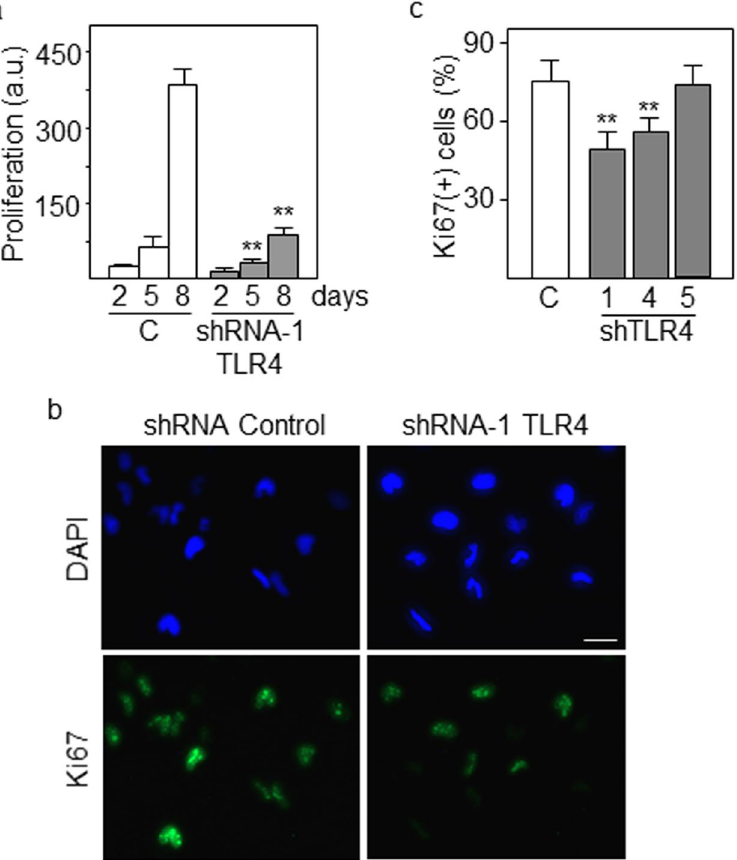
Figure 4. Proliferation of differentiating GSCs decreases following downregulation of TLR4. ( a ) GSCs were transfected with TLR4-specific shRNAs and proliferation was assessed at different time points of differentiation by using Alamar Blue reagent. a.u., arbitrary units. (b) Expression of the proliferation marker Ki67 and (c) quantification of Ki67-positive cells in GSCs with low levels of TLR4 following 5 days of differentiation. Cells were counterstained with DAPI. Histograms represent the mean ± SD of three independent experiments. Asterisks in grey bars represent significant differences ( ** p < 0.01) compared to empty (control) bars. Scale bar: 10 μ